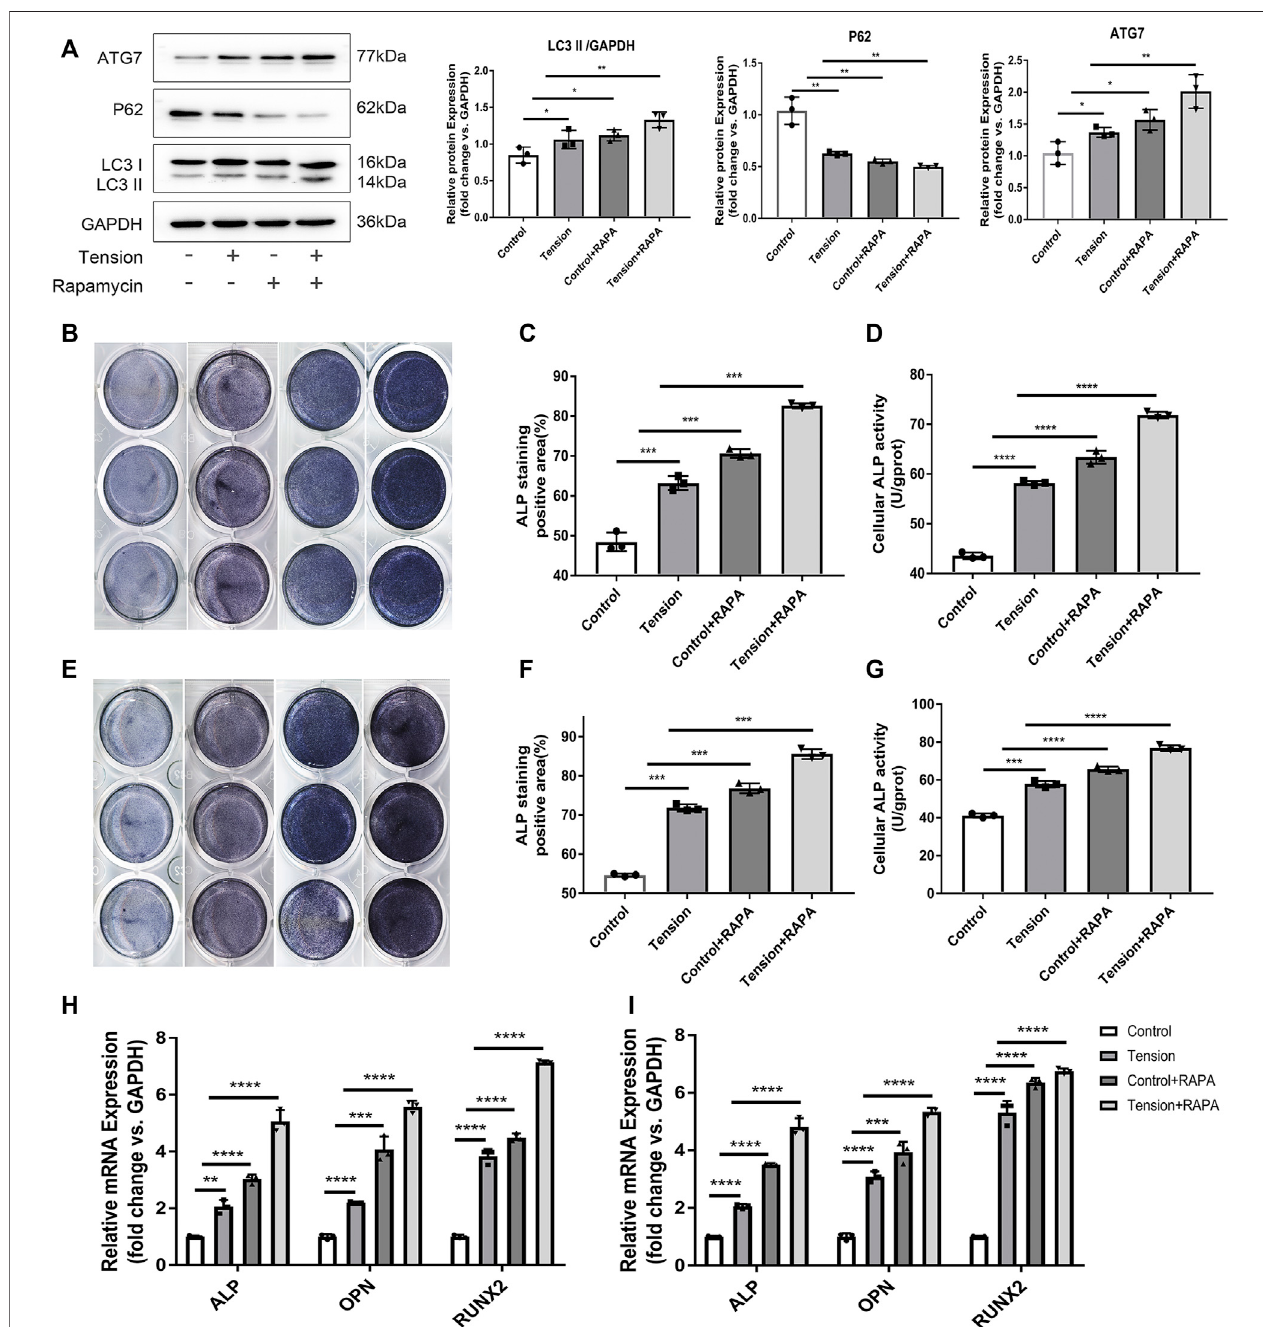
FIGURE 4 | Autophagy up regulated osteocyte-associated osteogenesis. (A) The cells were incubated with Rapamycin for 6 h before subjected to mechanical tension. LC3B ATG7 and P62 were detected by western Blot. GAPDH was used for normalization. (B) ALP staining of 3T3-E1 after induction of differentiation with CM from MLO-Y4 intheindicatedgroups. (C) Thequanti fi cationofALP+surface/B.Pm(%)of3T3-E1after induction ofdifferentiation withCMfrom MLO-Y4 intheindicated groups. (D) Cellular ALP activity (U/gprot) of 3T3-E1 after induction of differentiation with CM from MLO-Y4 in the indicated groups. (E) ALP staining of primary osteoblast precursor cells after indiction of differentiation with CM from MLO-Y4 in the indicated groups. (F) The quanti fi cation of ALP + surface/B.Pm(%) of primary osteoblast precursor cells after induction of differentiation with CM from MLO-Y4 in indicated groups. (H) The expression level of osteoblastic markers of 3T3-E1 was detected by RT-PCR. GAPDH was used for normalization. (I) The expression level of osteoblastic markers of primary osteoblast precursor cells was detected by RT- PCR GAPDH was used for normalization. All cell experiments were repeated 3 times and each time they were performed in at least 3 replicate wells. All data were showed as mean ± SD. * p ˂ 0.05 vs .